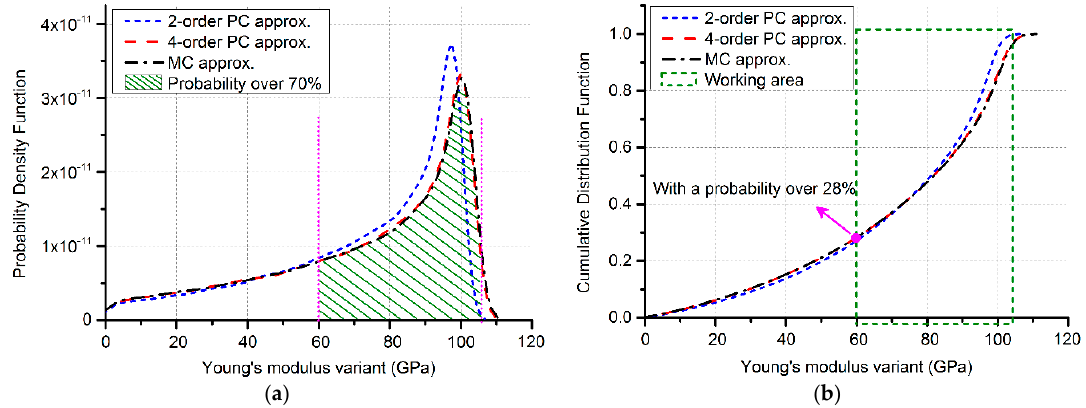
Figure 4. Topological SEM of GaAs MMIC-based MEMS beams: the left for bridge structures with the length ranging from 50 μm to 600 μm while the right for cantilevers with the length ranging from 50 μm to 380 μm . The spacing is 50 μm and 30 μm , respectively, for bridges and cantilevers. All the structures are 16 μm -width and 2 μm -thickness [36].